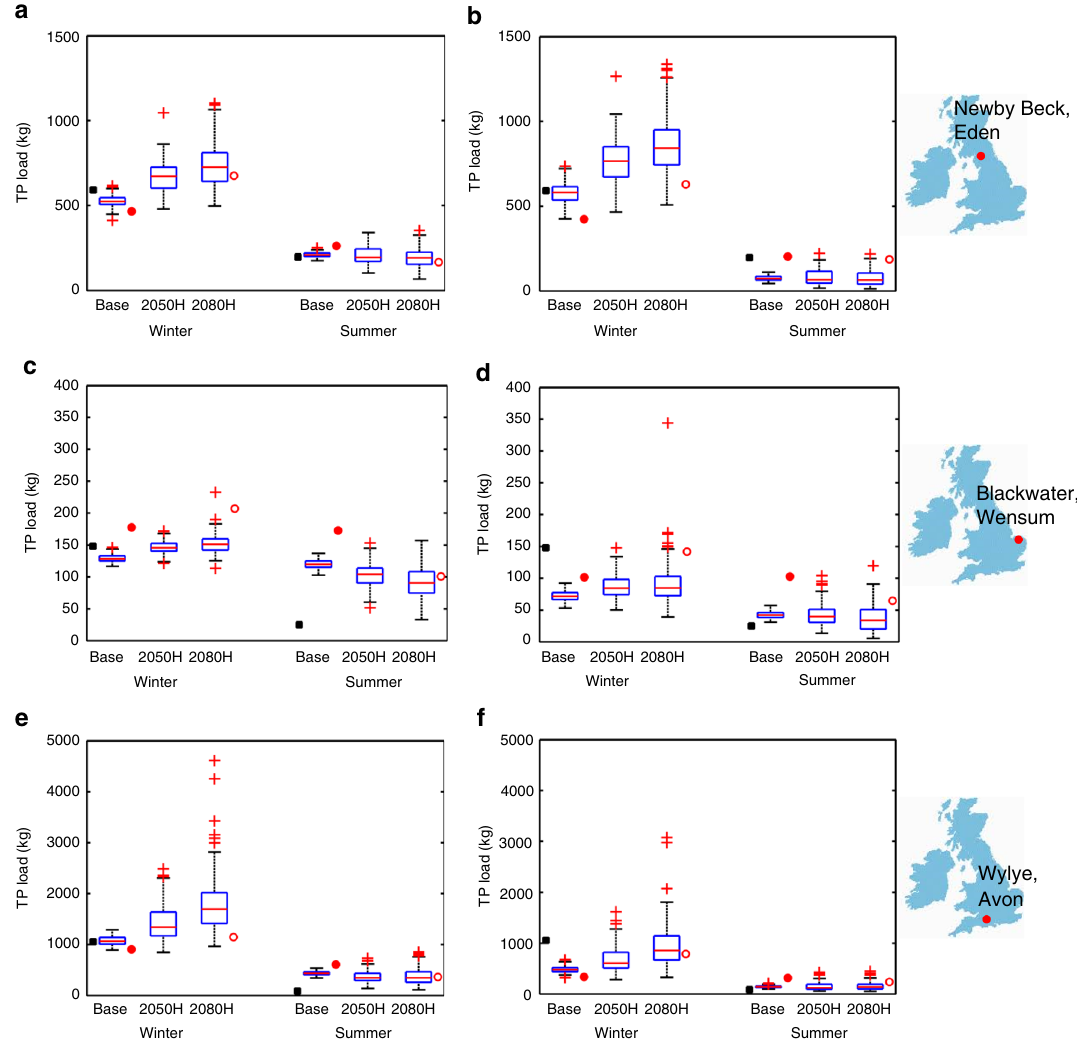
Fig. 2 Range of likely seasonal total phosphorus loads exported from three UK catchments in the future. Box and whisker plots show the range of likely winter and summer total phosphorus (TP) loads predicted by Data-Based Mechanistic models (DBM) and process-based Hydrological Predictions for the Environment model (HYPE). TP loads for Newby Beck catchment, Eden, winter and summer from DBM a and HYPE b ; TP loads for Blackwater catchment, Wensum, winter and summer from DBM c and HYPE d ; TP loads for Wylye catchment, Avon, winter and summer from DBM e and HYPE f for present day conditions (Base), and future conditions representing 2050s (2040 – 2069) and 2080s (2070 – 2099) from UK Climate Projections 2009 Weather Generator, high emissions scenarios (2050H and 2080H respectively). HYPE results are mean of all runs with behavioural parameter sets. Box indicates inter-quartile range (25th – 75th percentile), with median marked as red line ; whiskers extend 1.5 times interquartile range beyond box, or to furthest data point if smaller. Outliers (beyond whiskers ) are marked as red +. Observed winter and summer TP loads for 2012/13 are marked as black squares . Winter and summer TP loads predicted using rainfall from high-resolution climate model are marked as red fi lled circles (baseline conditions) and red un fi lled